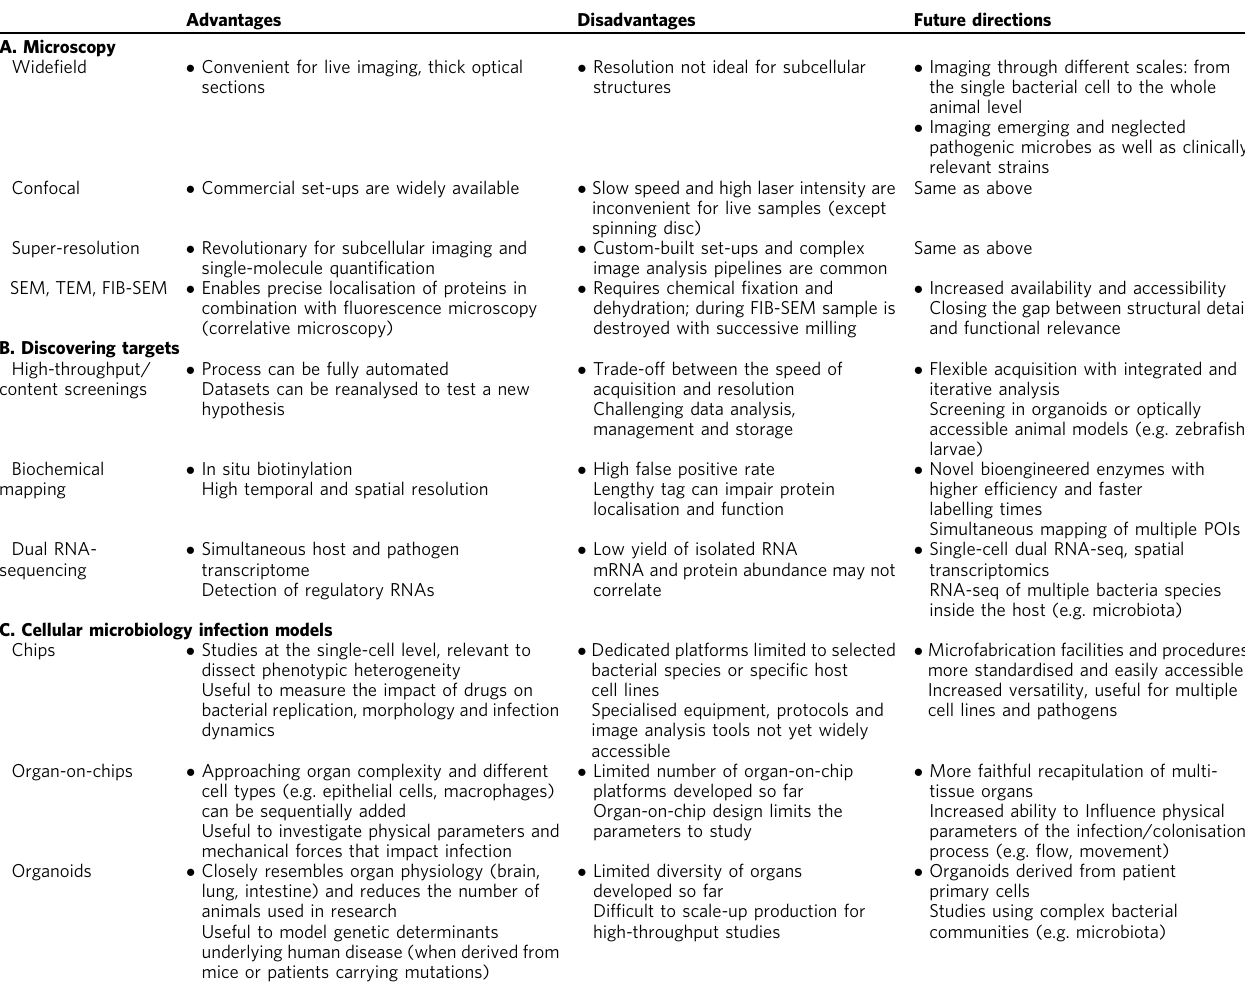
Table 1 Advantages, disadvantages and future directions for cellular microbiology